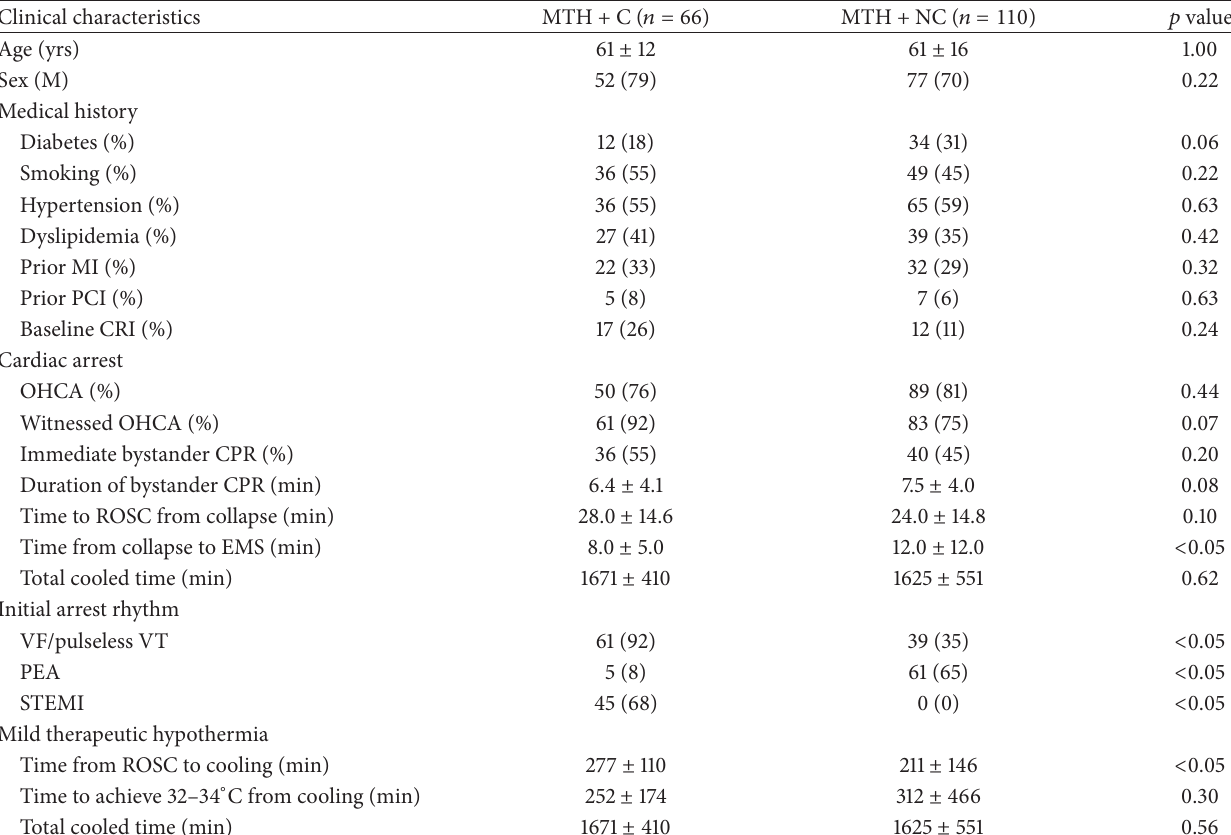
Table 1: Baseline clinical characteristics, prehospital arrest data, and cooling protocol of total population ( 𝑛 = 176 ). Clinical